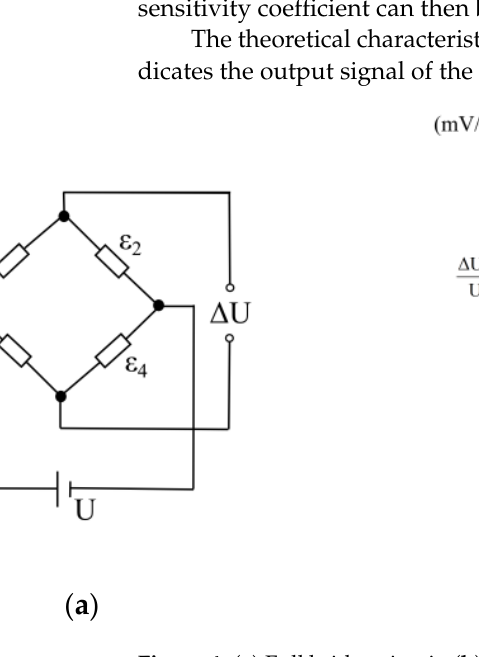
Figure 4. ( a ) Full bridge circuit; ( b ) sensor characteristic curve.